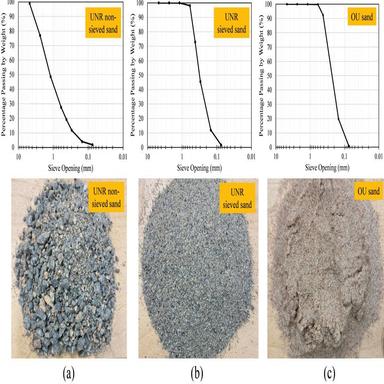
Different sand types used in the various NP-UHPC mixes in this study: (a) UNR non-sieved crushed aggregate sand, (b) UNR sieved crushed aggregate sand, and (c) OU fine masonry sand.